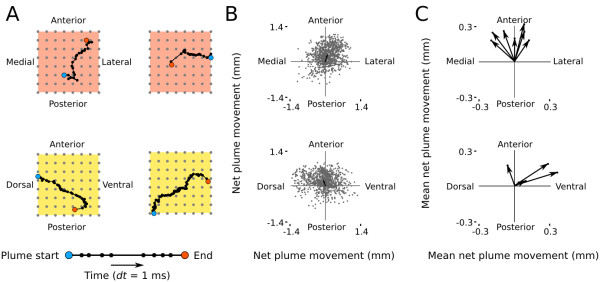
Traveling LFP plume trajectories. LFP plume mean location was determined in 1-ms time steps (see Experimental Procedures and Figure 2G). (A) LFP plumes can originate in different locations and travel along variable trajectories. Two examples from the same recording are given for each of the two orthogonal recording planes in the hyperpallium: horizontal (red) and sagittal (yellow; multi-electrode orientations are the same as in Figure 1A). (B) The net plume propagation along the two orthogonal axes of the multi-electrode array was calculated for every LFP plume in a recording; shown are two recordings from different birds. Every gray dot corresponds to one plume. Plume propagation is variable, but not completely random. The mean net LFP plume movement is indicated as a black arrow. (C) Mean net LFP peak movement vectors in the hyperpallium (one recording per bird; n = 11) illustrating the non-random nature of slow-wave propagation: plumes tend to propagate toward the surface of the brain.